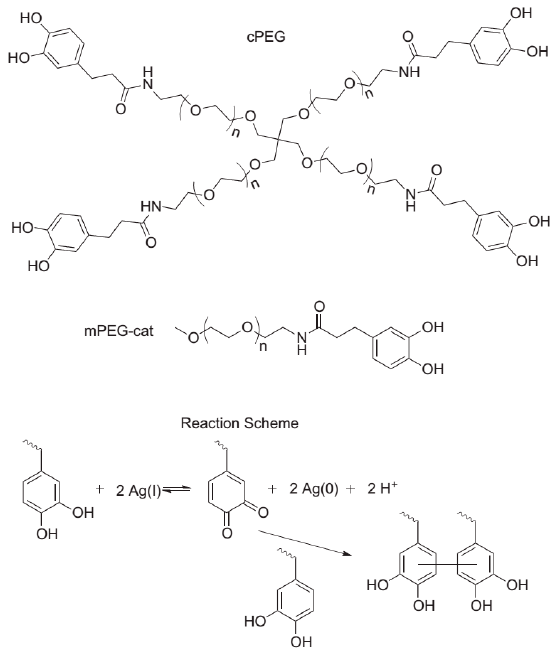
Figure 8. Molecules employed and reaction scheme for the fabrication of composite antibacterial hydrogels in one single step. branched catechol-derivatized poly(ethylene glycol) cPEG was used to form hydrogels and mono catechol-derivatized poly(ethylene glycol) mPEG-Cat was used for model gel permeation chromatography (GPC) studies of the reaction. Catechol reduction of Ag(I) allows for quinone-initiated radical coupling to catechols, as well as simultaneous silver nanoparticle formation. Reproduced with permission from